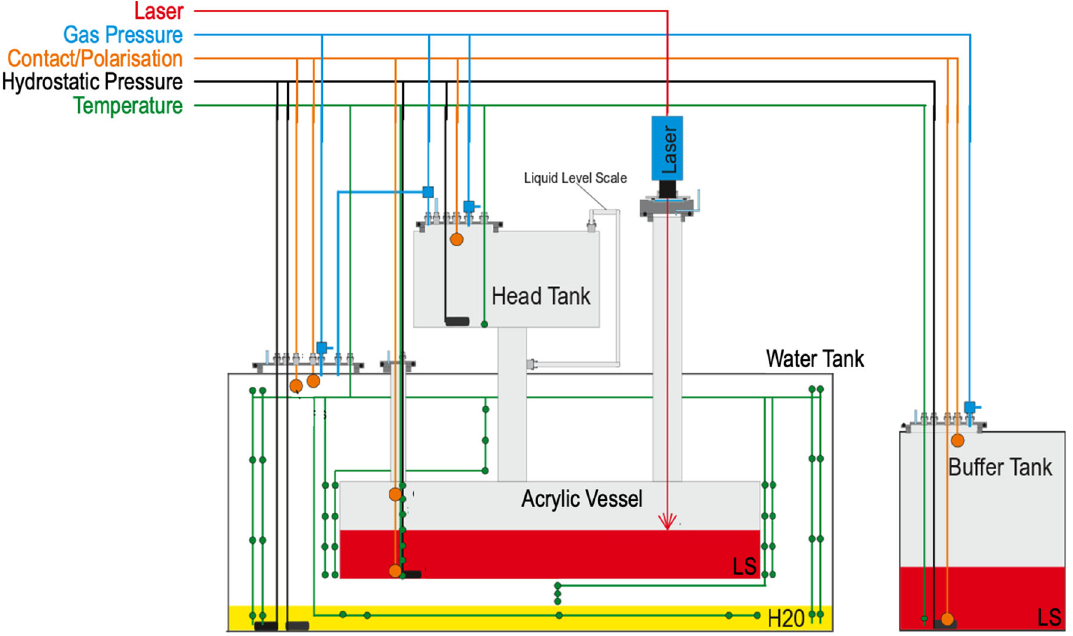
Fig. 6 Schematic drawing of the LM-system with temperature sensor grid. The thermometers are indicated in green, the HPSs in black while the level switches are drawn in brown. The gas pressure meters are shown in blue. The red line shows the position of the IR laser level